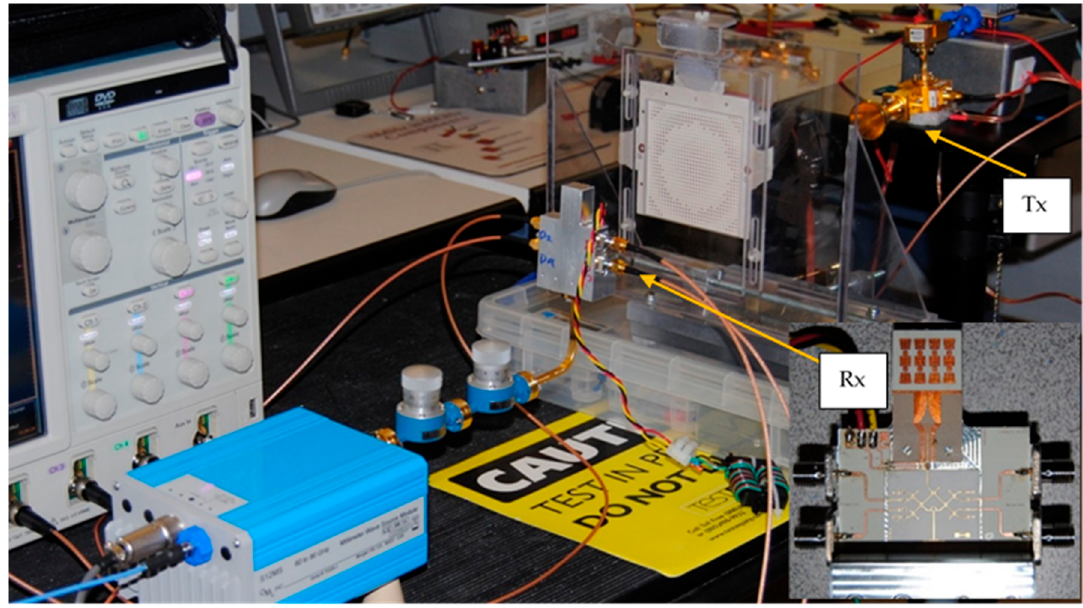
Figure 45. V-band multi-port receiver with integrated LNA and planar antenna array under test.